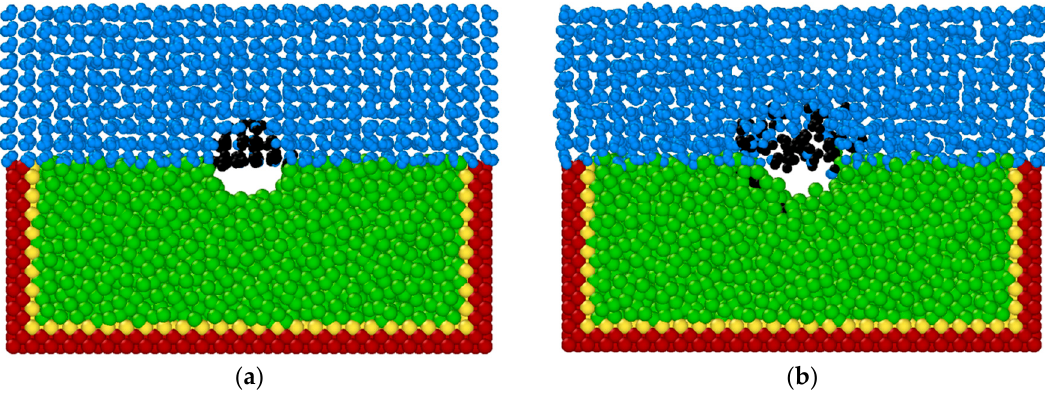
Figure 14. MD Simulation Snapshot Showing Thermal Blanket Formation during LA-LBMM Process in Static Mode ( a ) Initial Stage ( b ) Final Stage.